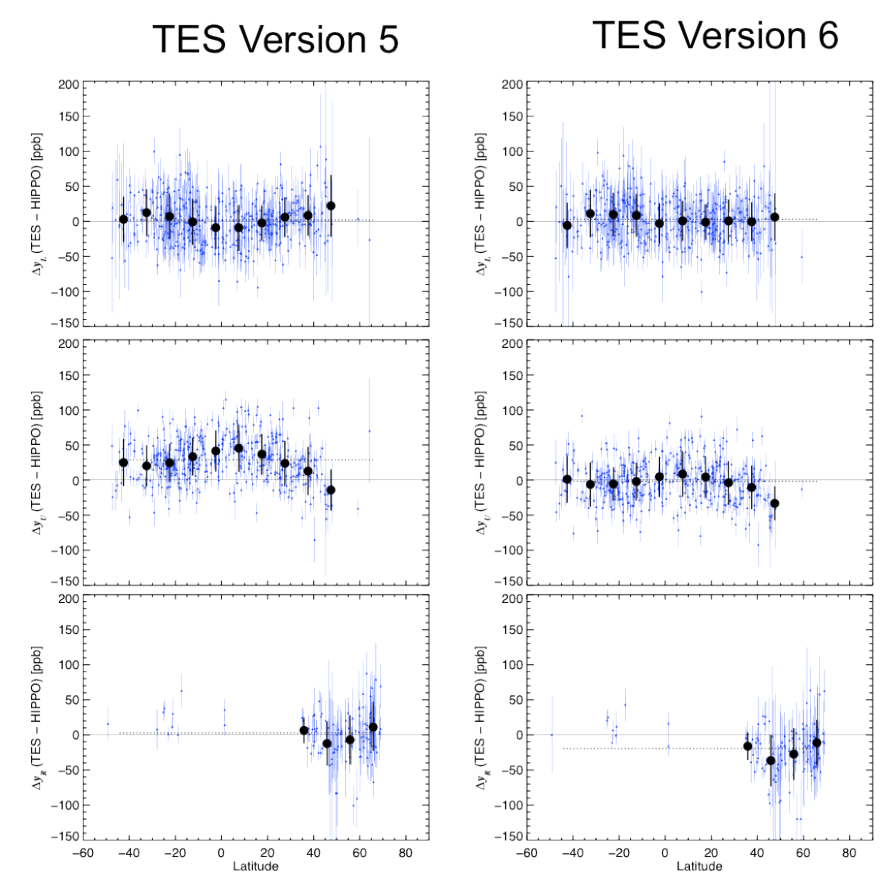
Figure 8. As in Fig. 5, but with the global bias correction (Eq. (7) and Sect. 5.4)